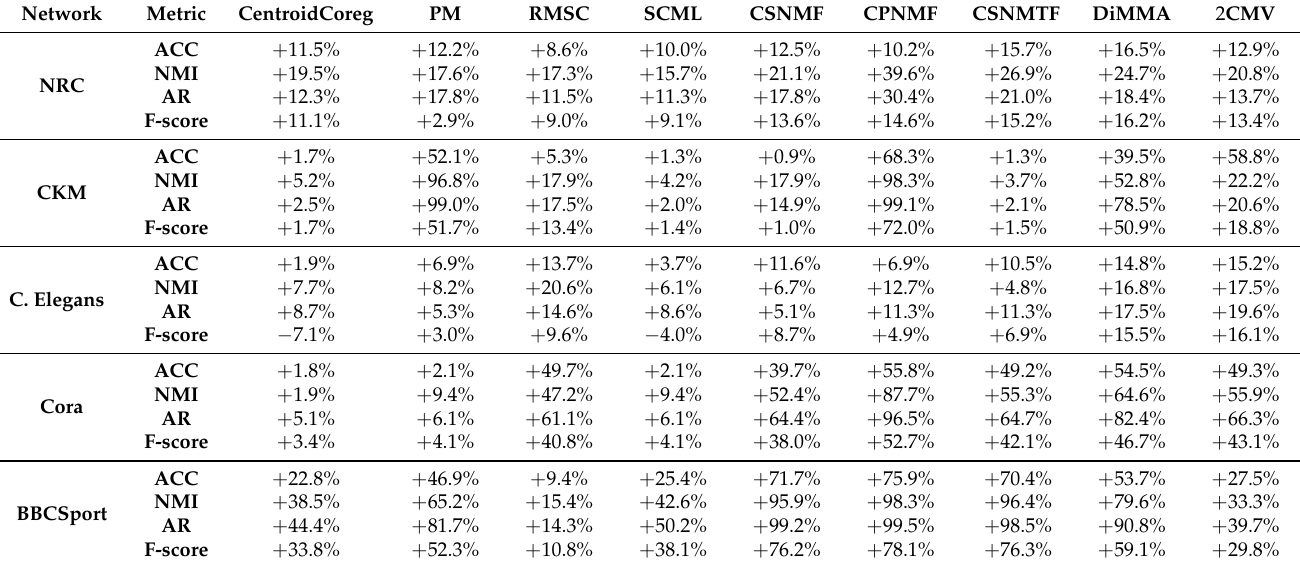
Table 5. Percent of improvement achieved by the proposed method over the other